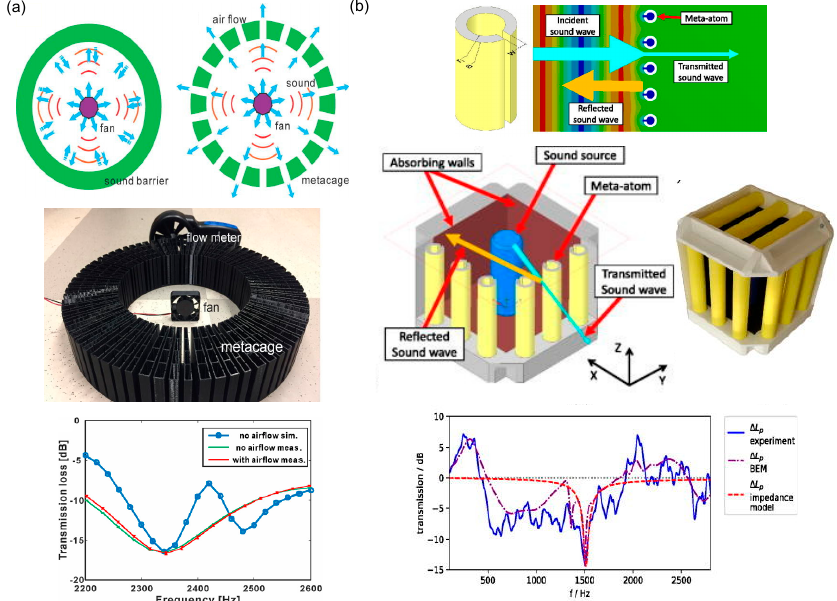
Figure 6. ( a ) Schematics of the proposed acoustic metacage design. Reprinted with permission